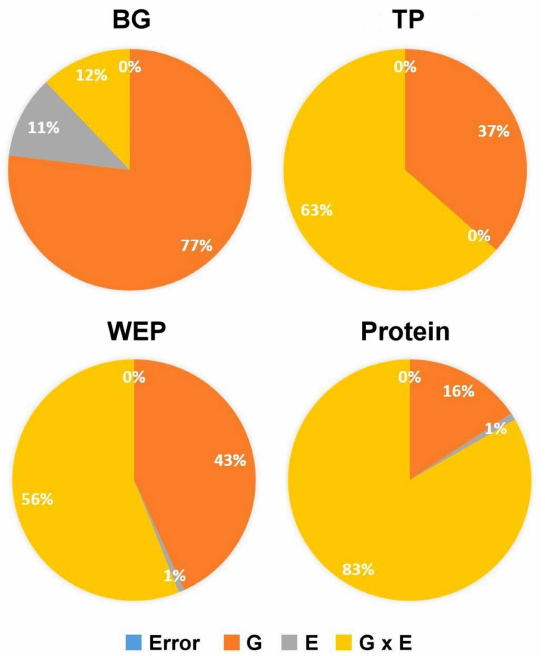
Figure 1. Variance components for grain compositional traits β -glucan (BG), arabinoxylan, measured as total- (TP) and water-extractable pentosans (WEP), and protein content in the Ae. biuncialis collection ( n =